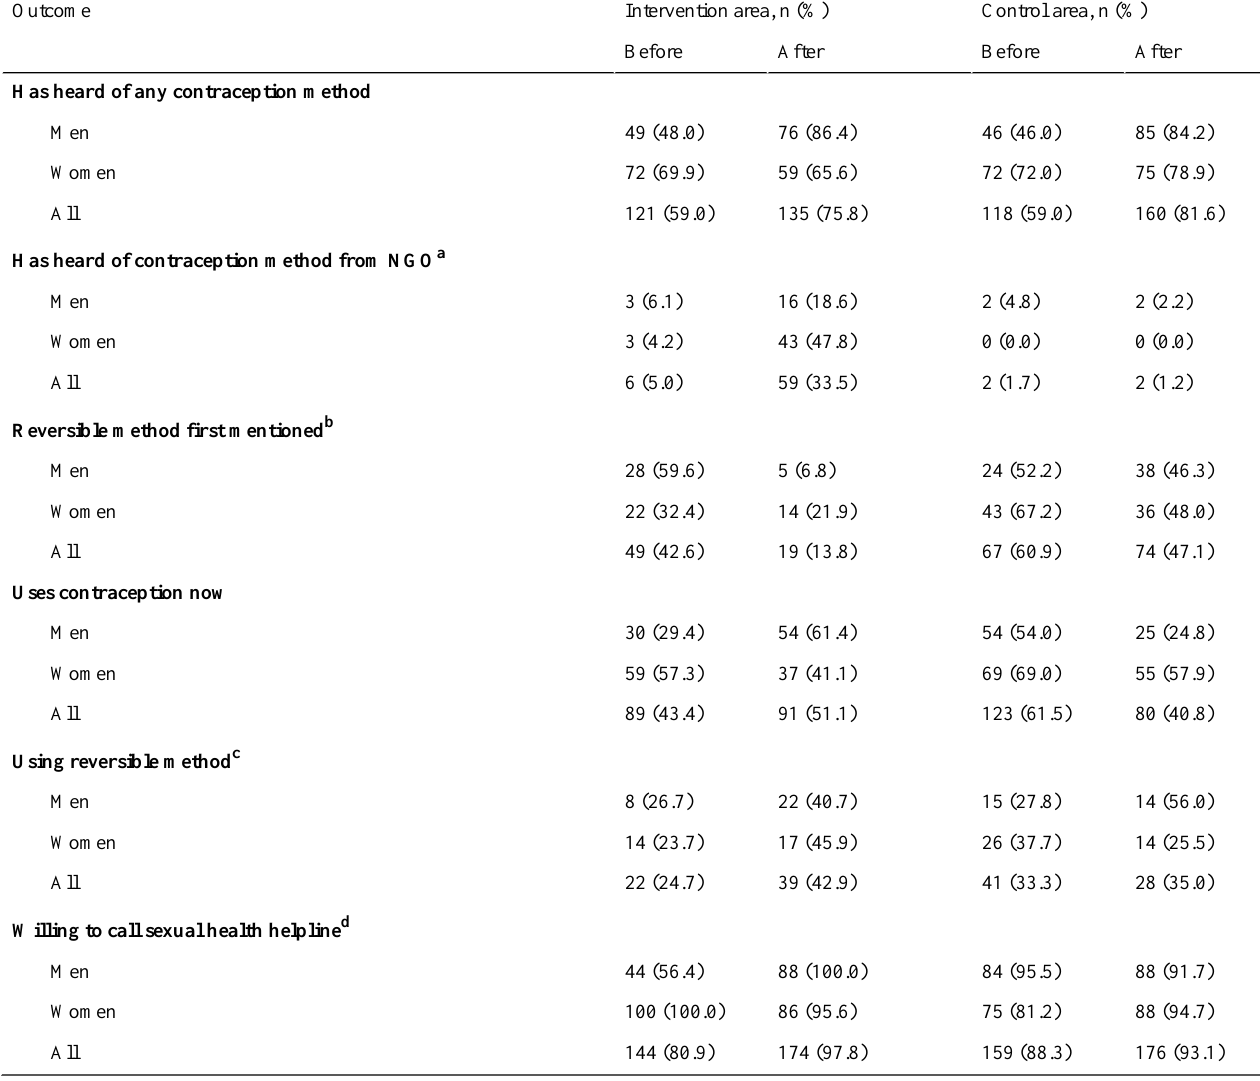
Table 2. Knowledge on contraceptive methods and sexual and reproductive health, access to contraception, and acceptability of mobile health support for sexual and reproductive health by study areas before and after the intervention (source: baseline and follow-up surveys, two primary health care areas in